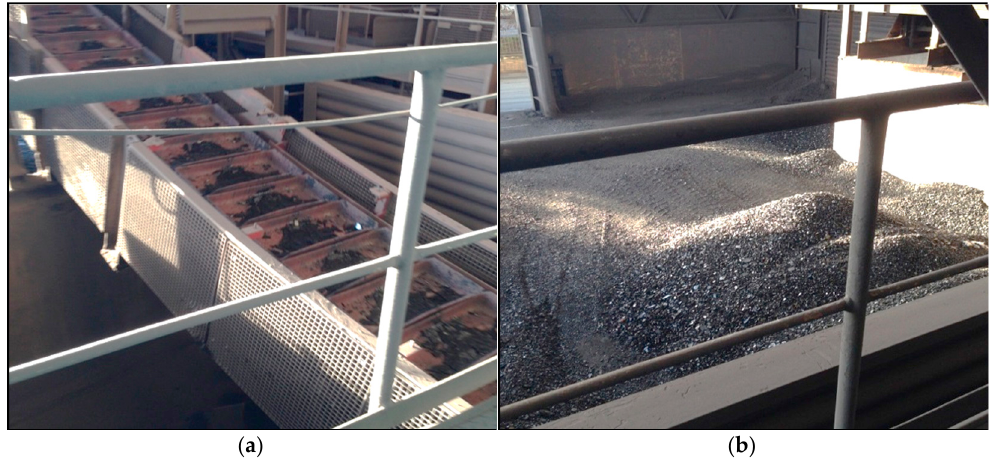
Figure 1. ( a ) Transport and cooling of cupola slag in trays; ( b ) detail of the stockpile at the